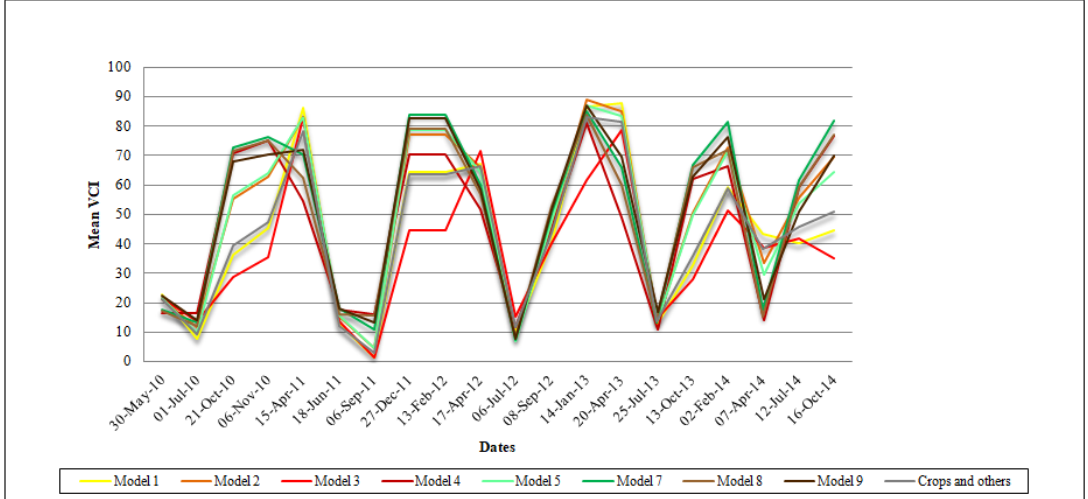
Figure 6. Vegetation Condition Index evolution (2010–2014) by fuel model.